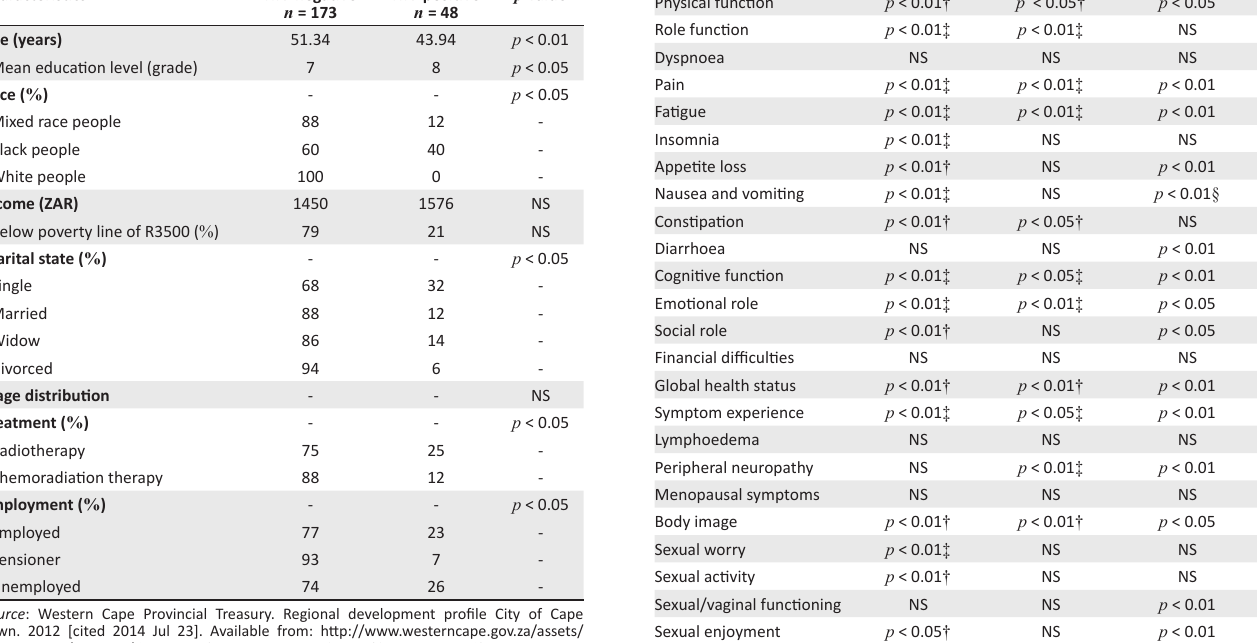
TABLE 1: Comparative demographic data of HIV-negative and HIV-positive women (poverty line as defined by the Western Cape Provincial Government). Characteristics